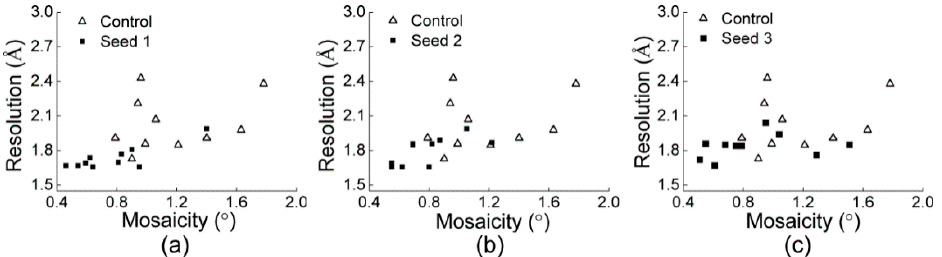
Figure 5. Combination of the resolution limit and mosaicity data for the lysozyme crystals in the same Figure. ( a ) in the presence of seeds 1, ( b ) in the presence of seeds 2, ( c ) in the presence of seeds 3.